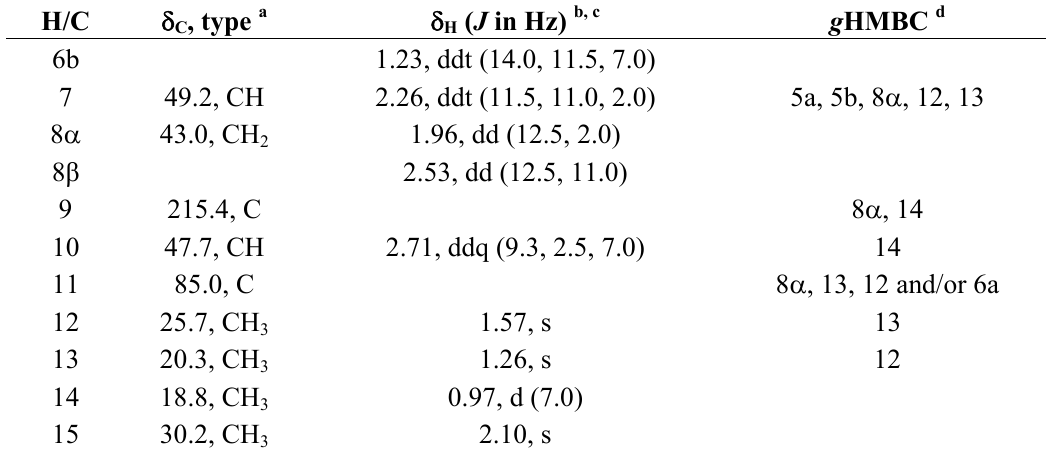
Figure 3. Selected nOe interactions for sesquiterpene 2 .